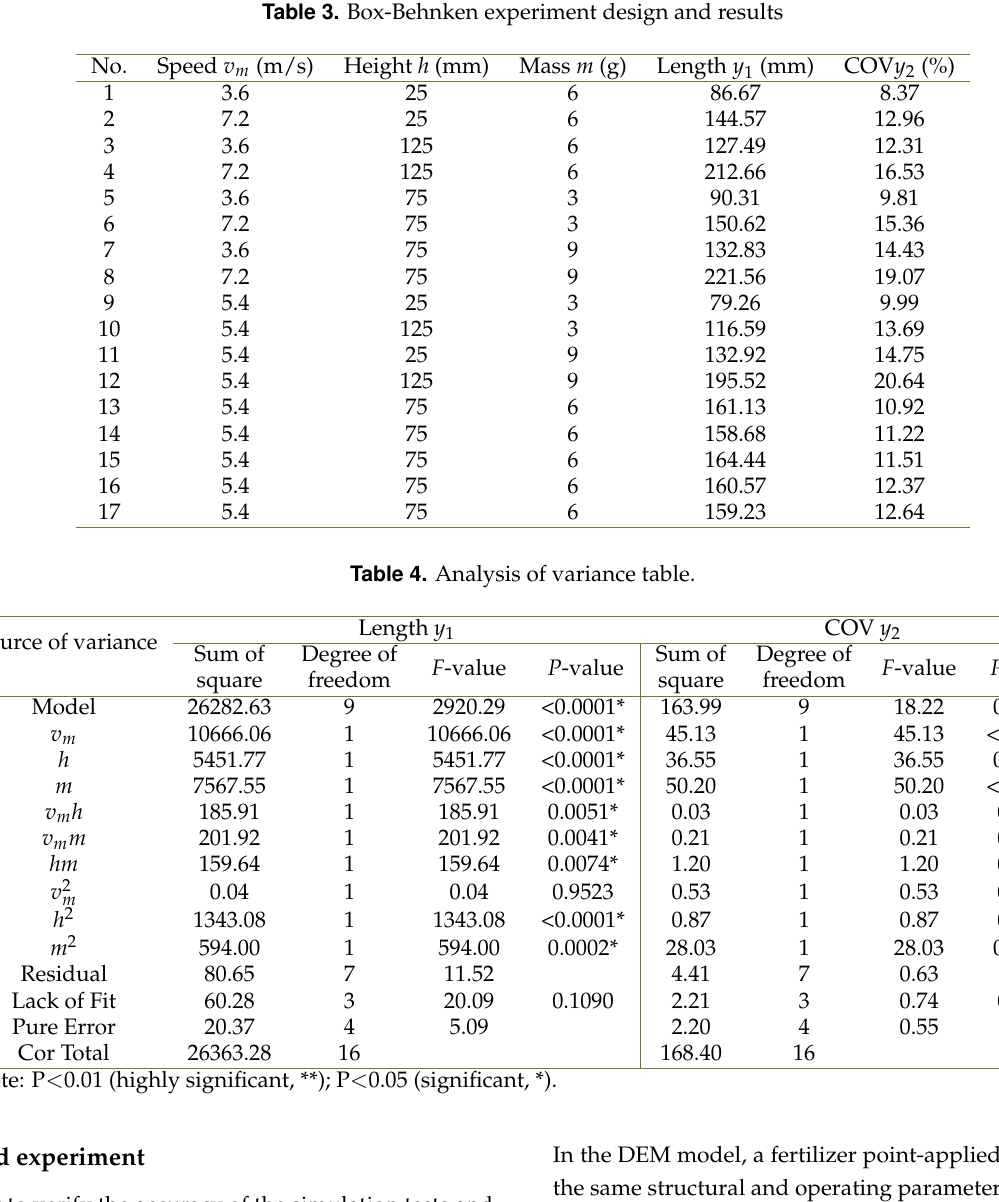
Table 3. Box-Behnken experiment design and results